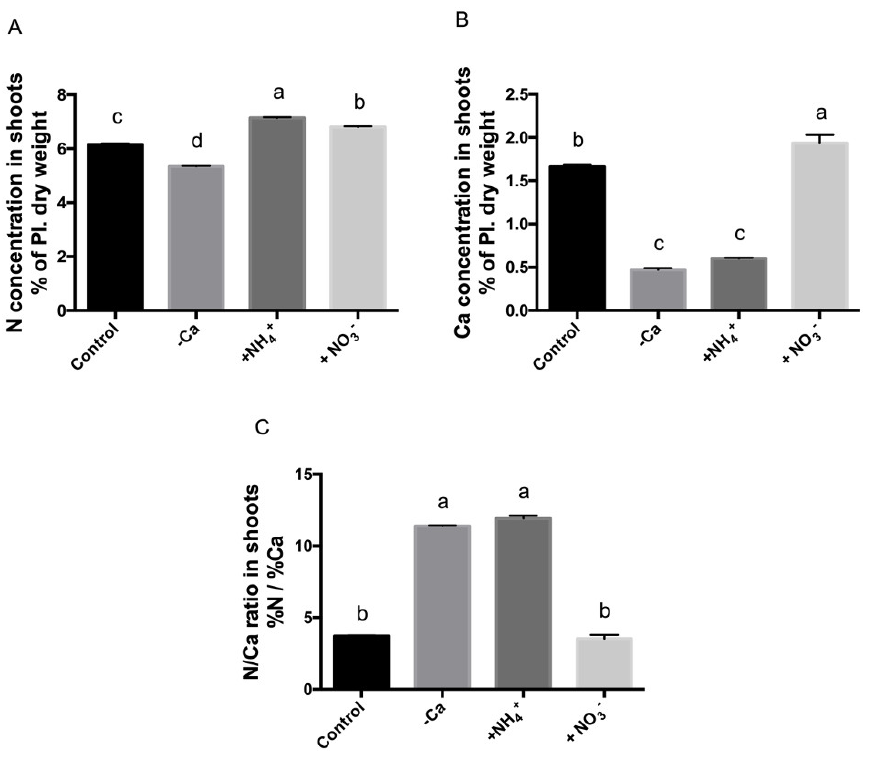
Figure 3. Nitrogen, calcium, and N/Ca ratio were altered by calcium deficit or ammonium and nitrate excesses in in vitro experiment. Tomato seedlings were grown with control media, with a calcium deficit, or with ammonium or nitrate excesses for 10 days in a growth chamber as described in the Materials and Methods section. Tomato seedlings were collected and dried at 45 °C in a dehydrator. Total nitrogen ( A ) and total calcium ( B ) were quantified as a percentage of plant dry weight. ( C ) Nitrogen/calcium ratio was calculated from the nitrogen and calcium percentage for each plant. a, b, c, d represents statistically significant differences with p < 0.05.